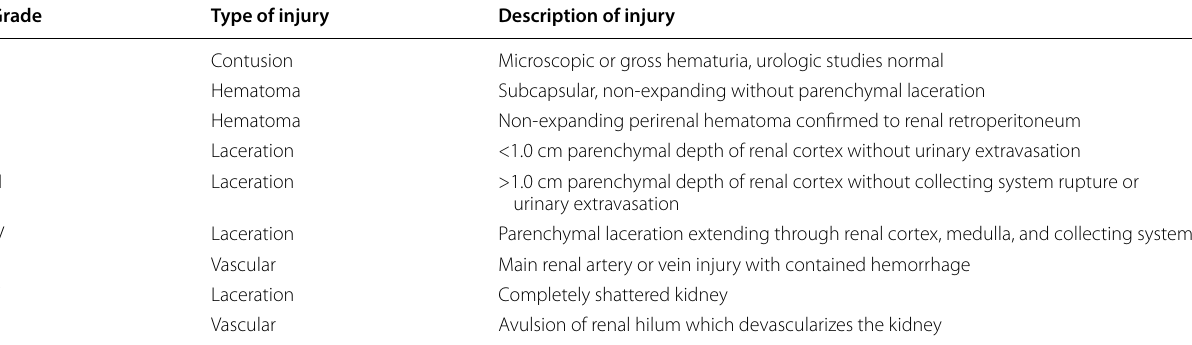
Table 1 Grading of renal trauma according to the American Association for the Surgery of Trauma (AAST) [14–16] Grade Type of